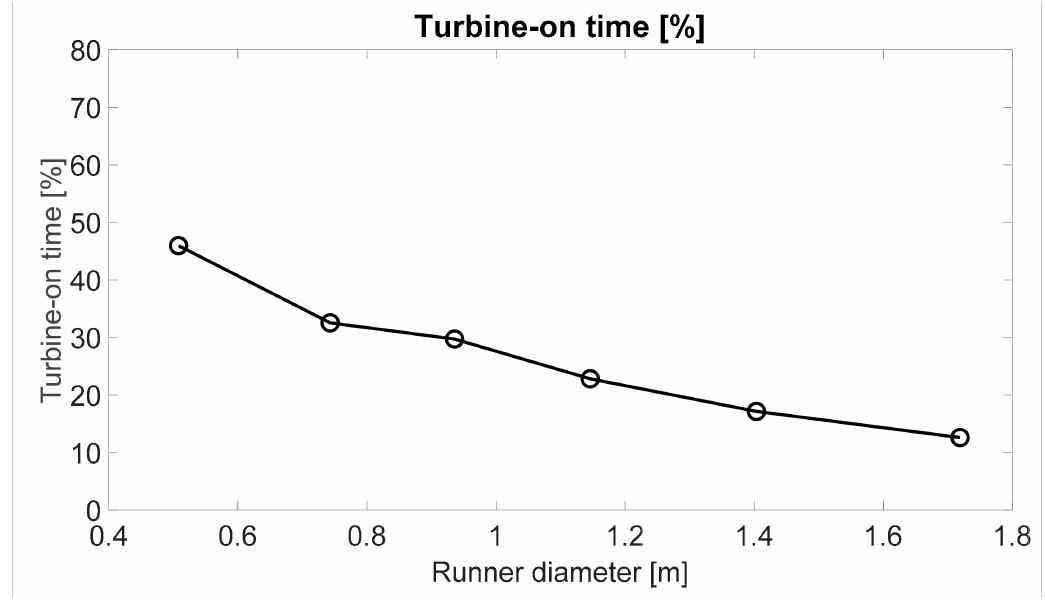
Figure 14. Turbine-on time as a function of the turbine runner diameter, at optimal configuration.